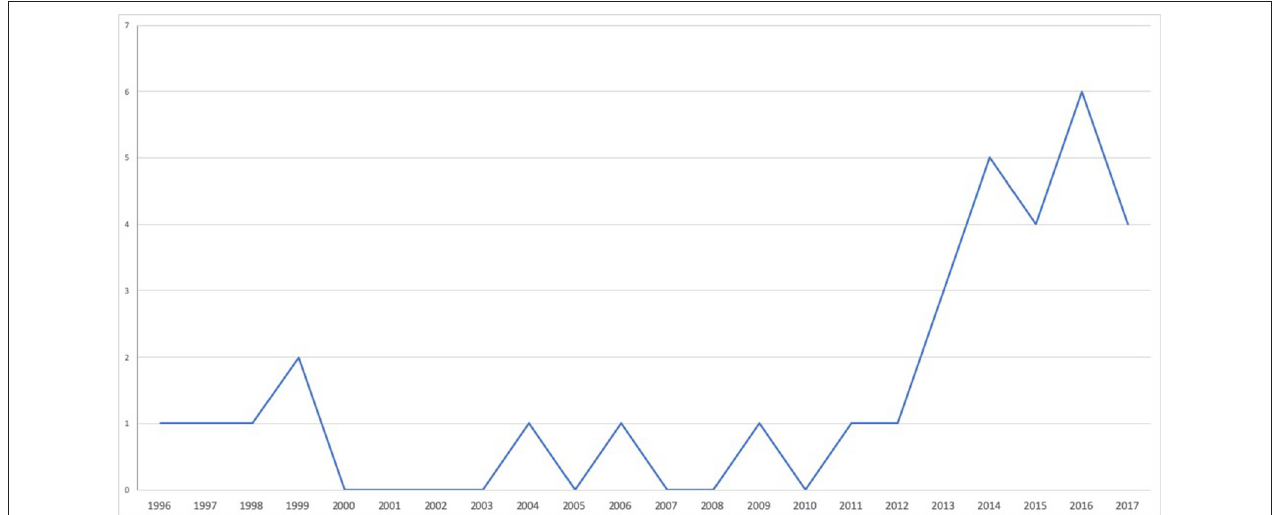
FIGURE 2 | Time distribution of the included published articles on young adult cardiac patients’ experience.